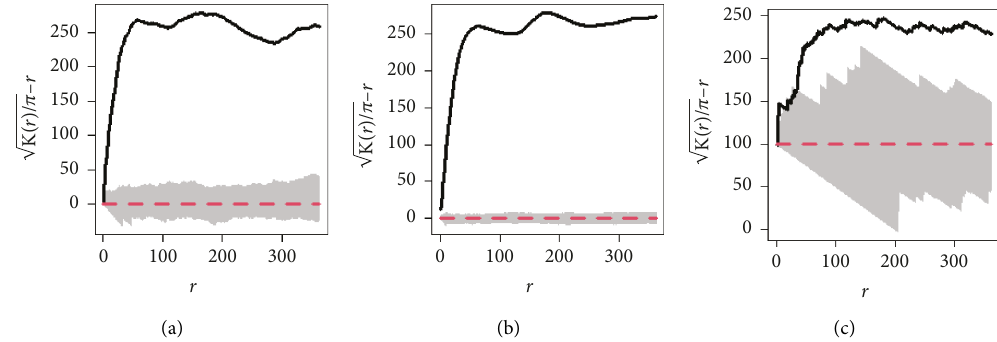
Figure 2: L ( r ) functions of C. parvifrons compared to a homogeneous Poisson null model, (a) seedlings, (b) rosettes, and (c) adults. The solid black line represents the homogeneous L ( r ) function observed in each case. The gray region represents the envelopes obtained by the simulation of the null model, and the dotted line represents the expected value of the null model (homogeneous Poisson